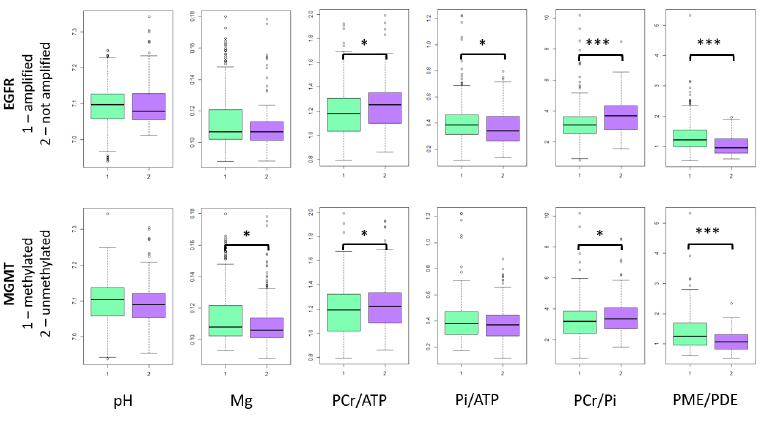
Figure 3. 31-P-MRS metabolites in tumor voxels. In the figure only whole sample results are presented, because slice results are mainly the same. *— p < 0.05, ***— p < 0.0001.